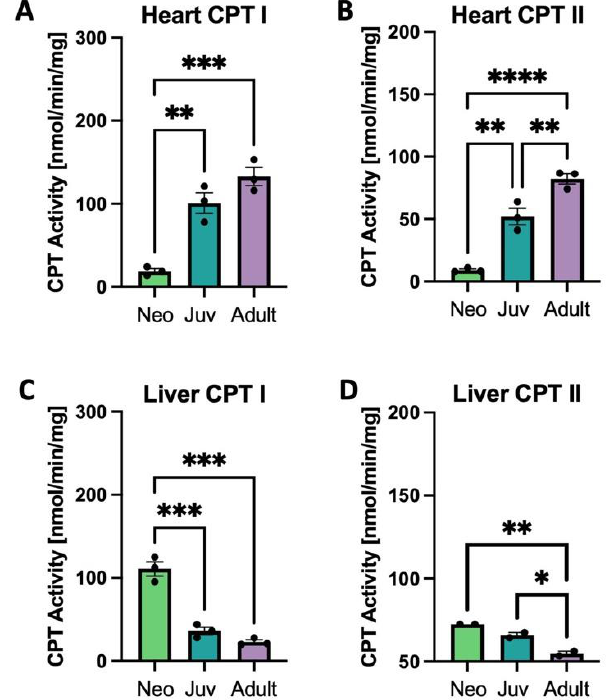
Figure 3. Carnitinepalmitoyltransferase (CPT) activity in heart and liver. CPT I and II activity in rat heart ( A , B ) and liver ( C , D ); * p < 0.05, ** p < 0.01, *** p < 0.001, **** p < 0.0001; N = 3 separate animals. Error bars represent standard error of the mean.